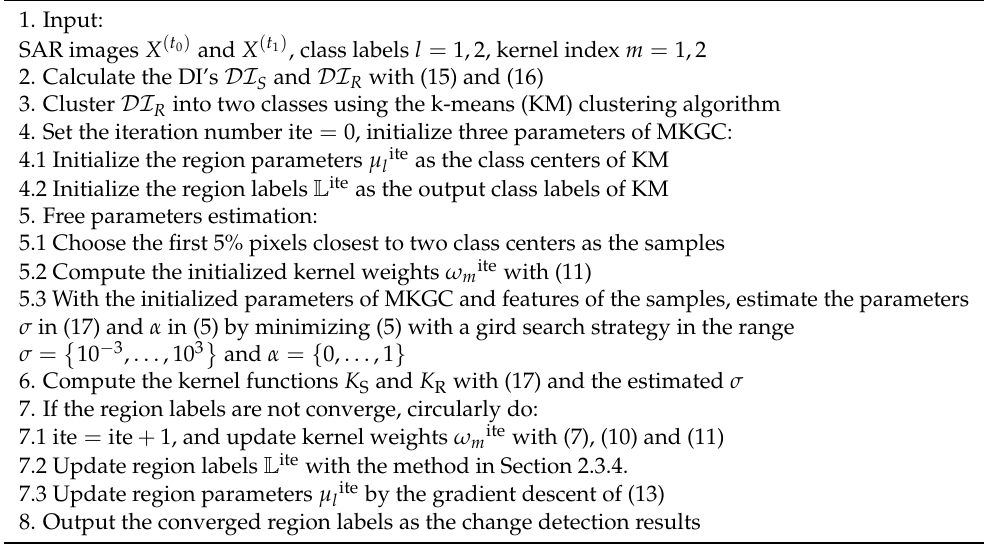
Table 1. Steps of MKGC change detection